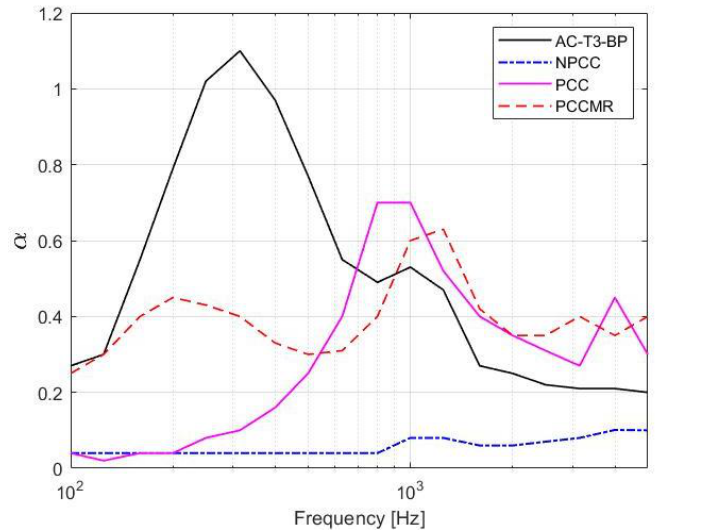
Figure 13. Comparison of the sound absorption coefficient α measured for panel AC-T3-BP and that measured in [12] for non-perforated cardboard element (NPP), perforated (PCC), and perforated cardboard element with multiresonators